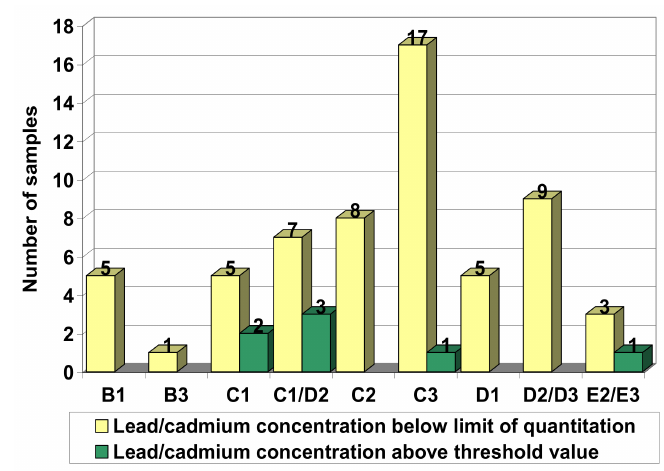
Figure 4. Distribution of produce samples based on lead concentrations and respective quadrants in Baroševac.